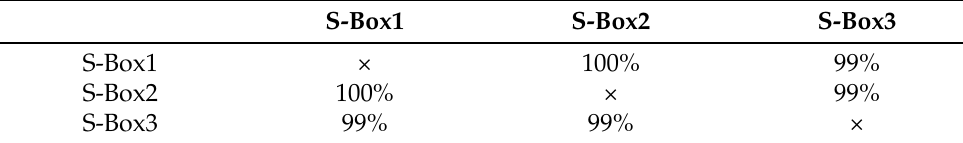
Table 4. The average differences between the created S-Boxes (1, 2, and 3).